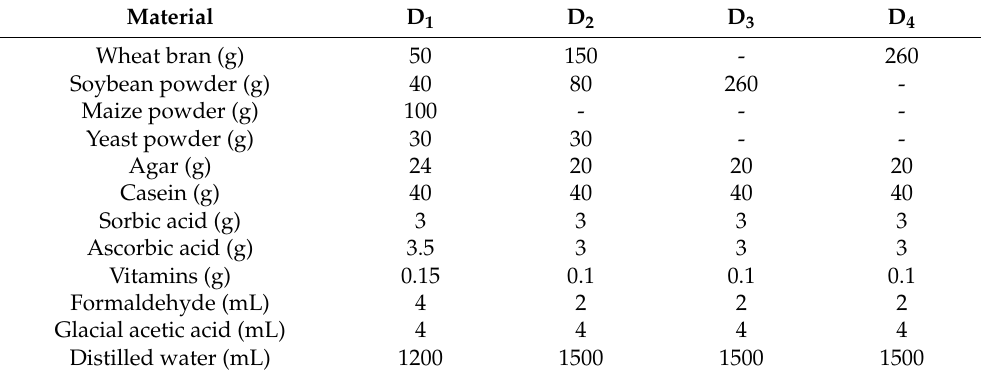
Table 1. Formulas of four artificial diets fed to fall armyworms ( Spodoptera frugiperda ). Material D 1 D 2 D 3 D 4 Wheat bran